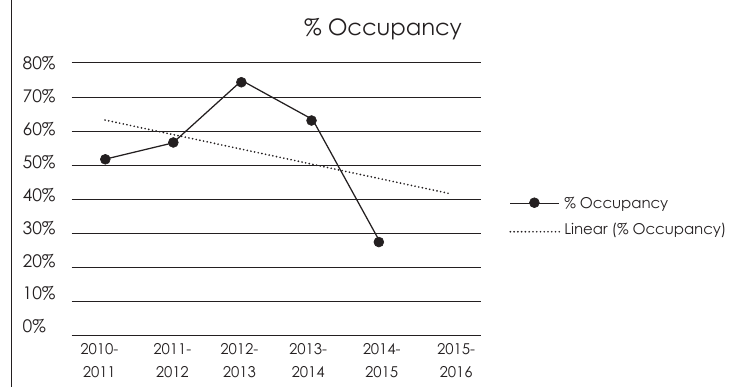
Figure 1: Subject silo occupancy